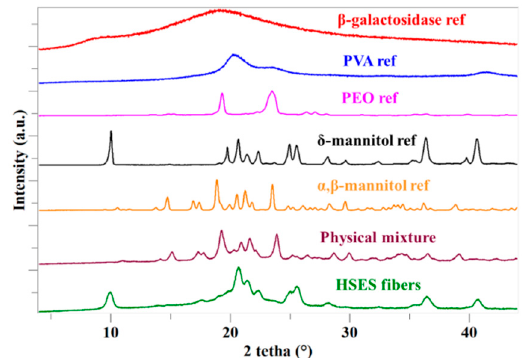
Figure 5. X-ray powder diffraction (XRPD) patterns of β -galactosidase; polyvinyl alcohol (PVA); polyethylene oxide (PEO); δ -mannitol; α , β -mannitol; the physical mixture of PVA, PEO, α , β -mannitol, and β -galactosidase; and the ground electrospun PVA + PEO + mannitol + β -galactosidase. To evaluate the molecular interactions, FTIR spectroscopy was applied on the samples (Figure 6).